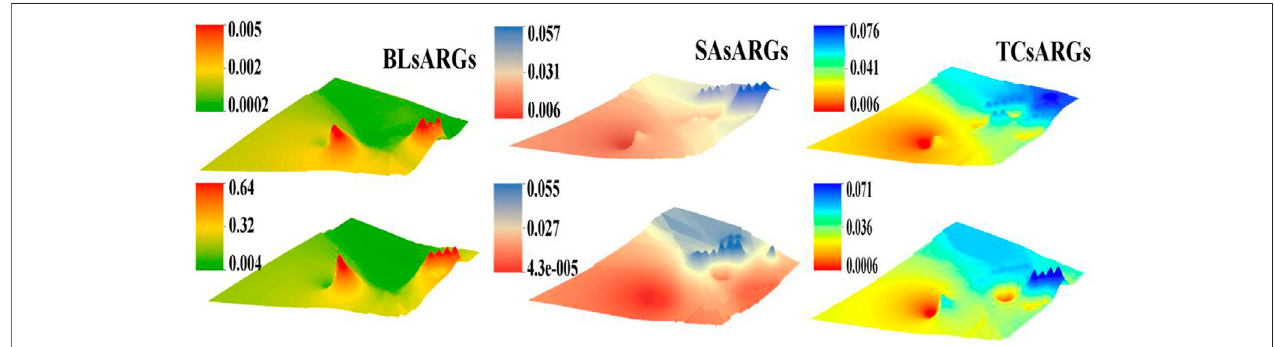
FIGURE2| Thespatialdistributionofthe β -lactam,sulfonamide,andtetracyclineARGsatdifferentdepthsofthesoilsamples(topmapsrepresentthe10 cm-deep soil and the bottom maps represent the 50 cm-deep soil).